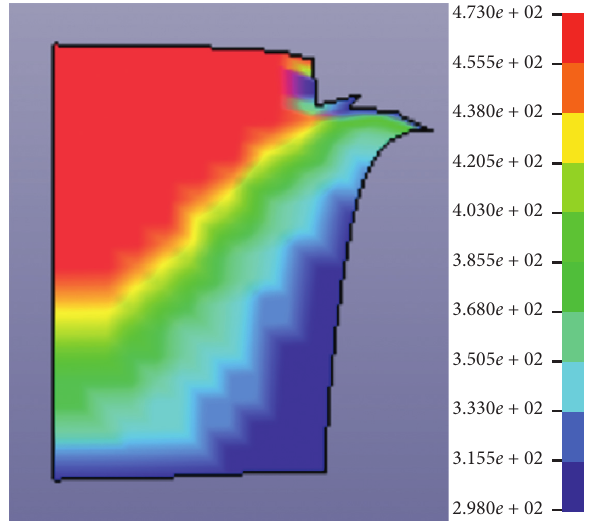
Figure 7: Temperature contour of the reactive material